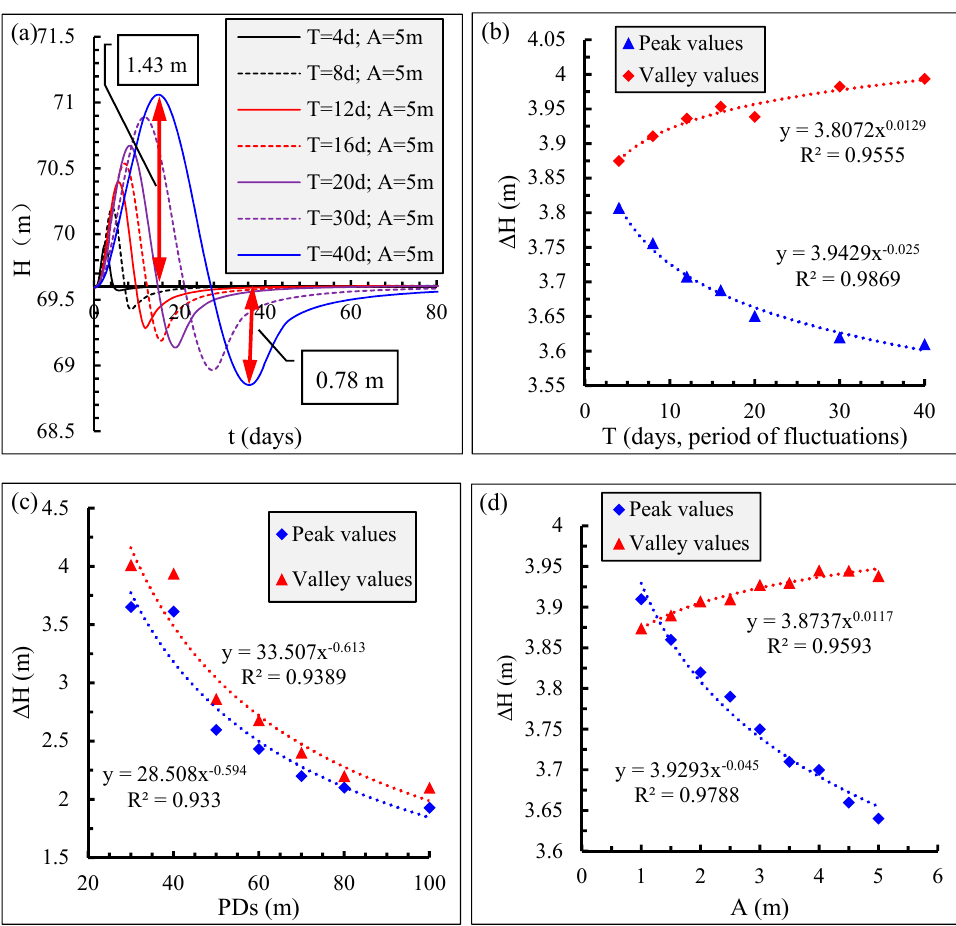
Figure 4. GW table and the increment values of peak/trough GW table ( ∆ H) driven by the fluctuating surface water levels and injections at the observation point. ( a ) the variations of water tables driven by the fluctuating surface table. ( b ) the variations of ∆ H with the change of the period of fluctuations. ( c ) the variations of ∆ H with the change of the penetration depth of SW. ( d ) the variations of ∆ H with the change of the fluctuation amplitude.